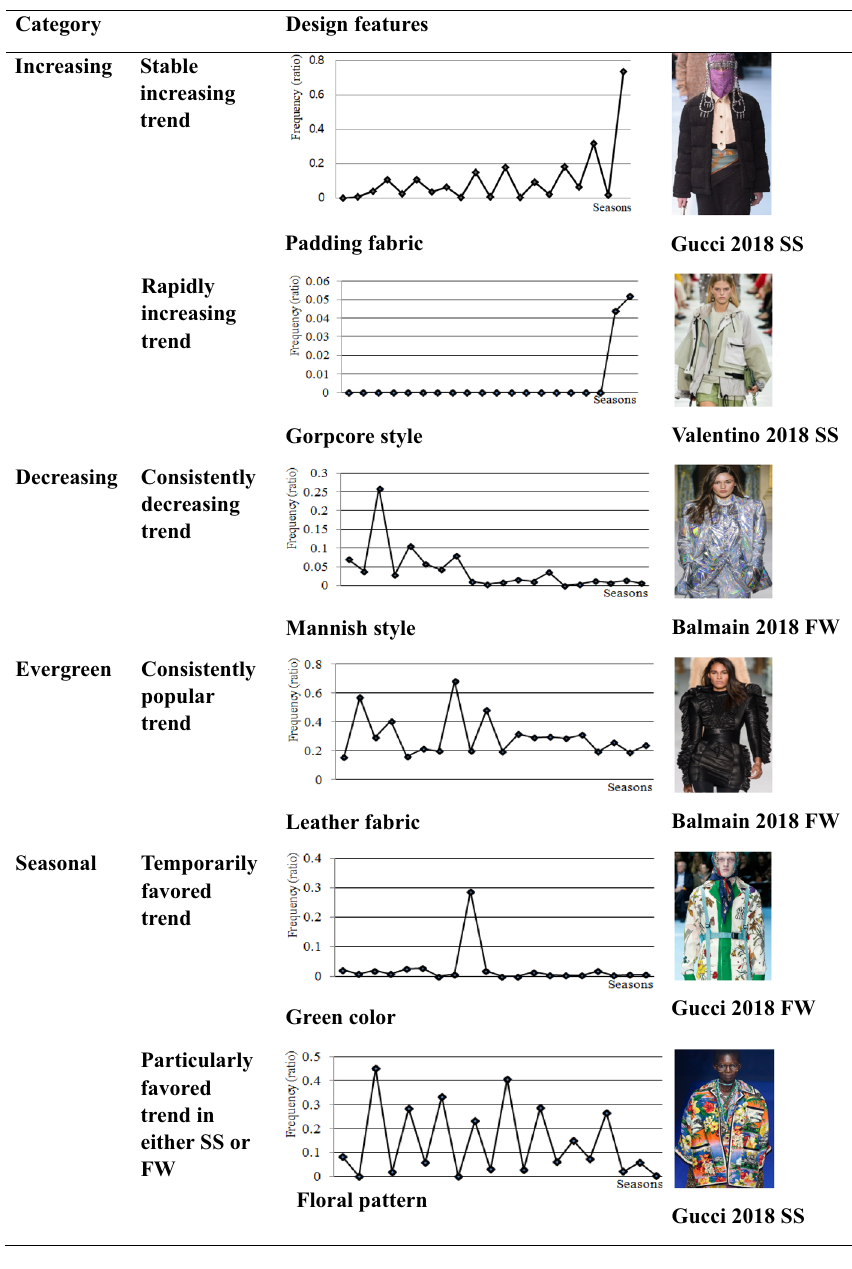
Table 2 Time-series cluster result on the jacket design feature (since 2009 spring/summer to 2018 fall/winter